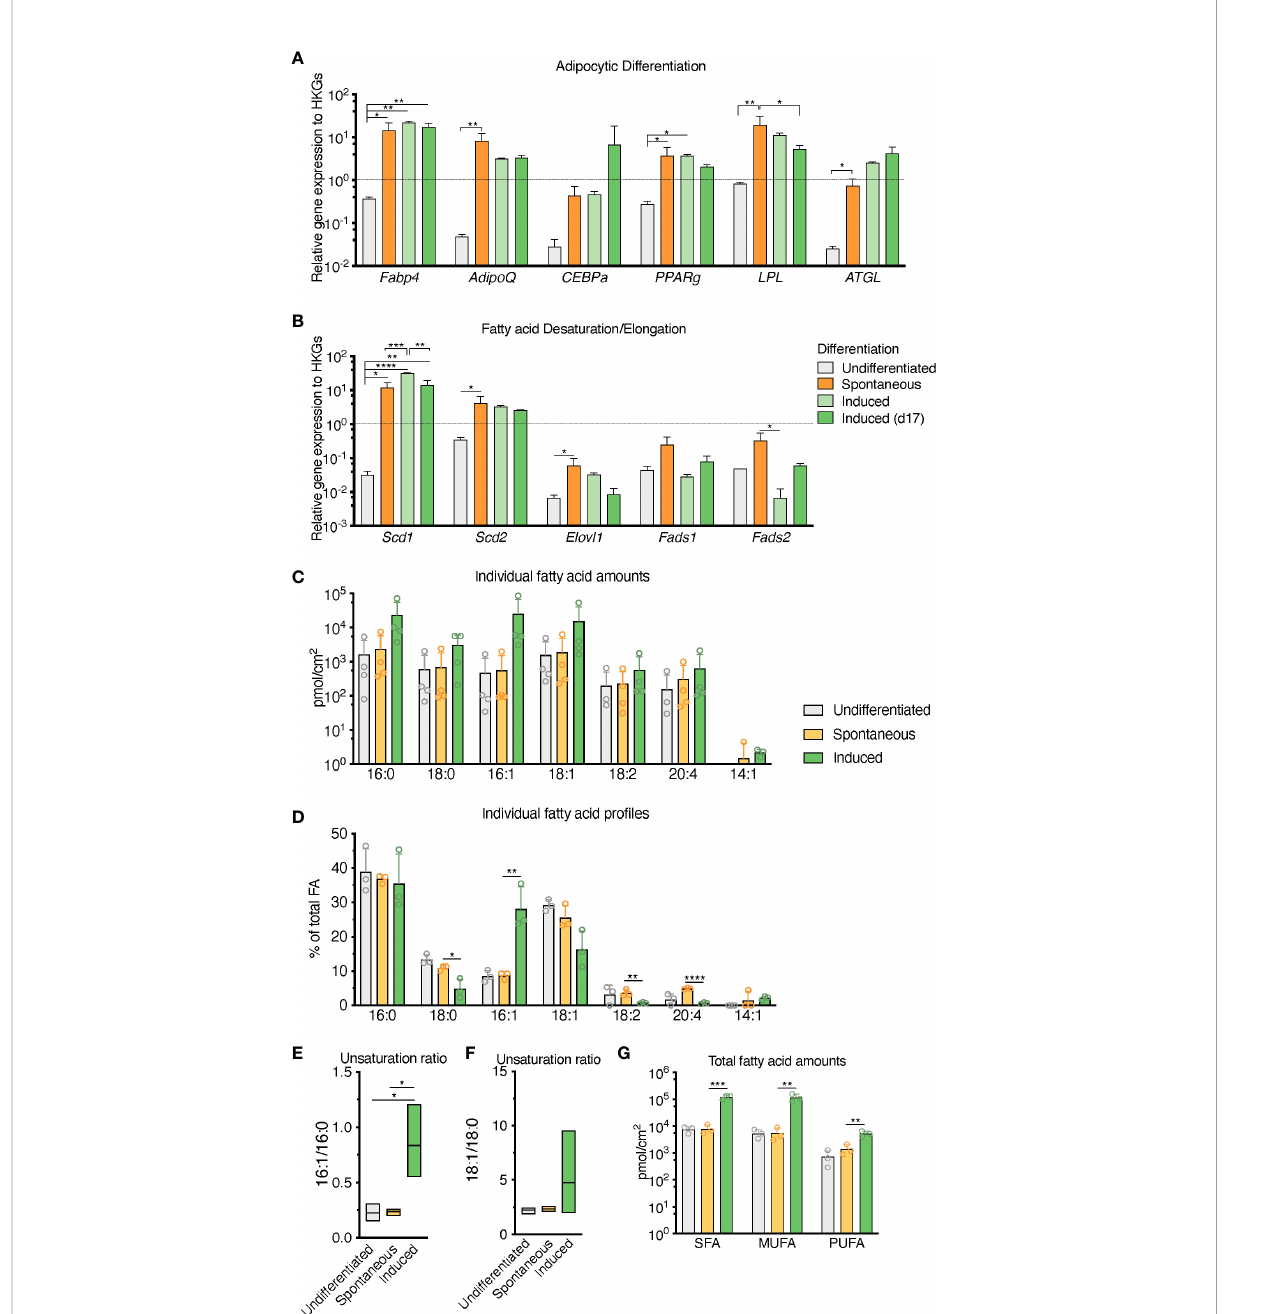
FIGURE 2 Population level differences in lipid composition are more marked than differences in the canonical adipocytic transcriptional signature for spontaneous versus induced cultures. (A) RT-qPCR markers of adipogenesis are increased in induced OP9-adipocytes. (B) Desaturase expression is highest in day 17 induced OP9-adipocytes while one of the elongases in fatty acid de novo synthesis is decreased. ****P < 0.0001, ***P < 0.001, **P < 0.01, *P < 0.05 by Bonferroni ’ s multiple comparisons test. Error bars represent mean ± s.d. (n = 3 independent experiments). (C – G) HPLC analysis of spontaneously differentiated or induced OP9 adipocytes revealed (C) nuances of the most abundant saturated, mono-, and polyunsaturated lipid species, with (D) overall total higher unsaturation content in induced versus spontaneous conditions. (E) Percentage of individual fatty acid species reveals (F) a greater 16:1/16:0 unsaturation ratio in the induced condition. (G) Unsaturation ratios 18:1/18:0 were not signi fi cantly different. ****P < 0.0001, ***P < 0.001, **P < 0.01, *P < 0.05 by ANOVA test with Bonferroni ’ s multiple comparisons adjustment. Error bars represent mean ± s.d. (n = 3 independent experiments). HKGs; housekeeping